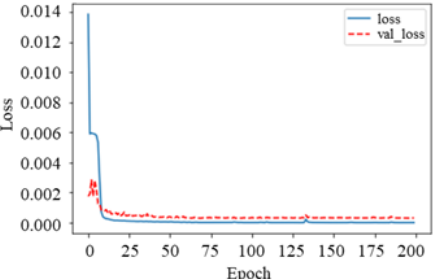
Figure 8. Loss for training data and validation data in Case 2.